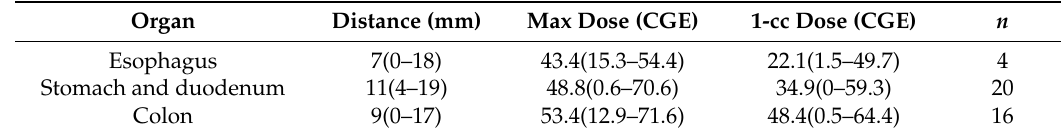
Table 4. Gastrointestinal tract